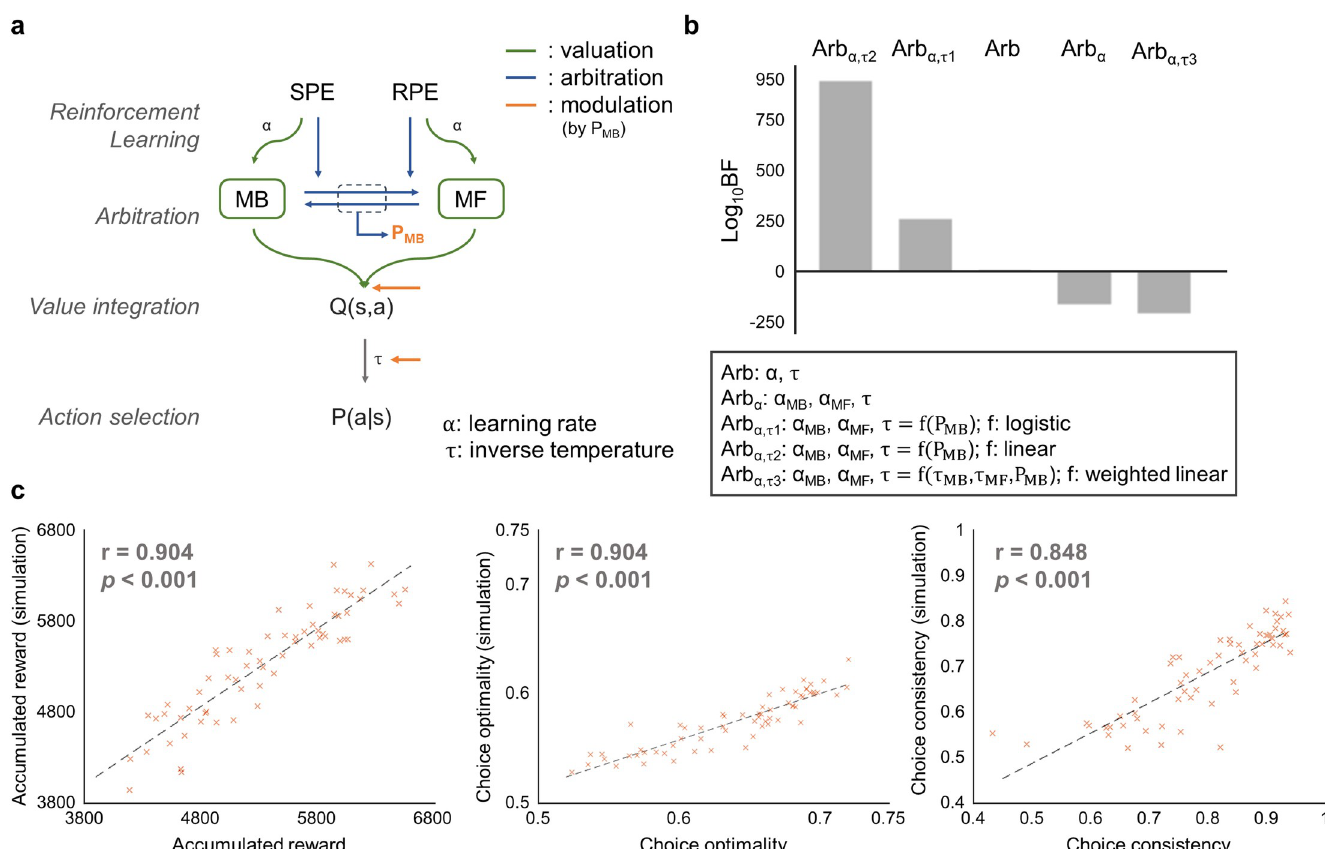
Fig 3. Computational model of dynamic arbitration control. (a) Computational model to investigate dynamic control mechanisms to arbitrate between model- based (MB) and model-free (MF) RL. Two separate RL systems update an action value and reliability of its prediction by using prediction errors (SPE and RPE, respectively; green). The reliability values of the two systems were then used to compute the model choice probability (P MB ) (blue). The model choice probability guides both the value integration and value-action conversion process; both effects are indicated by the orange arrow. (b) Model comparison analysis. We used a Bayes Factor (BF) for comparing the goodness of fit while penalizing for the model complexity. All BF are compared based on the previous model, Arb. Arb refers to the computational model proposed in (Lee et al., 2014). Additional versions of arbitration control consider separate learning rates and dynamic exploitation. Arb α assigns is the same as Arb α , except for the assumption that the degree of exploitation is a separate learning rates to two different systems (i.e. use α MB , α MF instead of α ). Arb α , τ function of the model choice probability. The best version of model uses the degree of exploitation ( τ ) as a weighted sum of the model-based and the model-free exploitation parameter ( τ MB and τ MF , respectively) with the model choice probability P MB (i.e. τ = P MB � τ MB + (1-P MB ) � τ MF )). (c) Model recovery of the behavioral data. To assess whether the free parameters of the best version of the model encapsulate the essence of choice behavior, we ran the behavior recovery analysis. For this, we generated simulated behavioral data from the model fitted to each individual participant’s original behavioral data. Shown are the comparison between behavioral measures from the original and the simulated behavioral data. Dots are the averaged simulated results for each